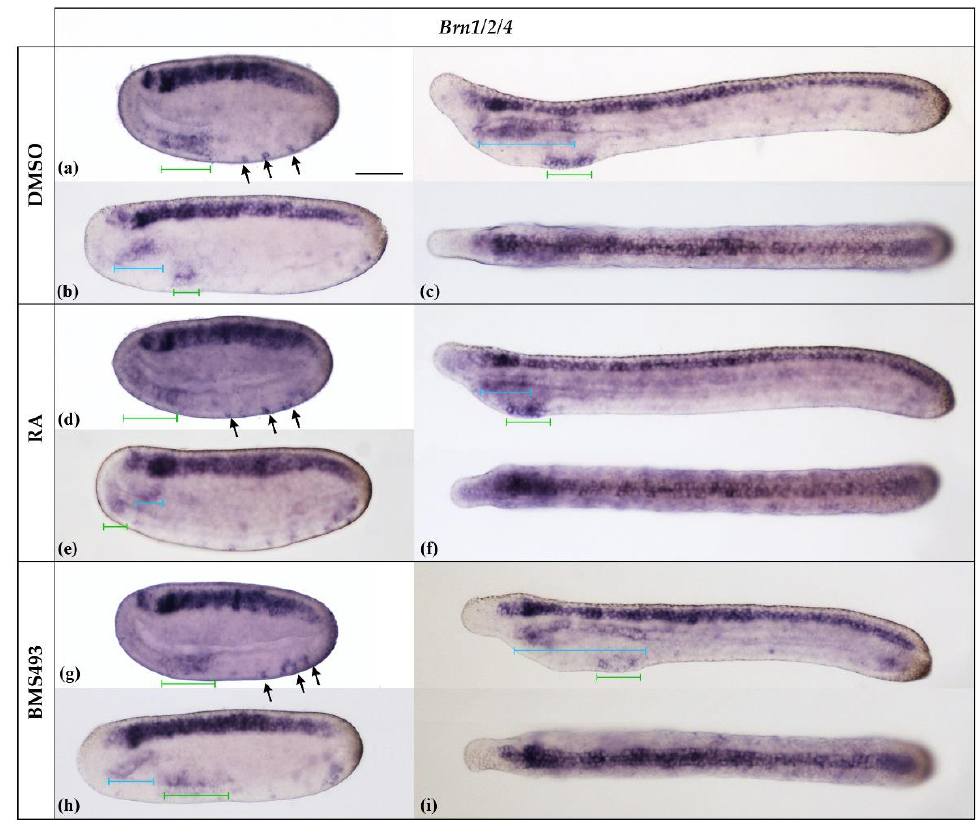
Figure 5. Expression of Brn1/2/4 in N2-, N4-, and T1-stage Branchiostoma lanceolatum embryos. ( a – c ) Control embryos (DMSO-treated). ( d – f ) Retinoic acid (RA) signaling activation with all- trans retinoic acid (RA). ( g – i ) RA signaling inhibition with inverse agonist BMS493. Brn1/2/4 is strongly expressed in the neural plate and ventral pharyngeal endoderm (green bars) as well as in differentiating ectodermal sensory neurons (arrows) at the N2 stage ( a , d , g ). This pattern is maintained at later stages, with the addition of a new expression domain in the dorsal anterior endoderm at the N4 stage (blue bars) ( b , e , h ), which persists at the T1 stage ( c , f , i ). Whole mount N2- and N4-stage embryos are shown in lateral views; T1-stage embryos are shown both in lateral (top) and dorsal (bottom) views. The anterior is to the left. The scale bar in ( a ) is 50 μm and is valid for all panels.